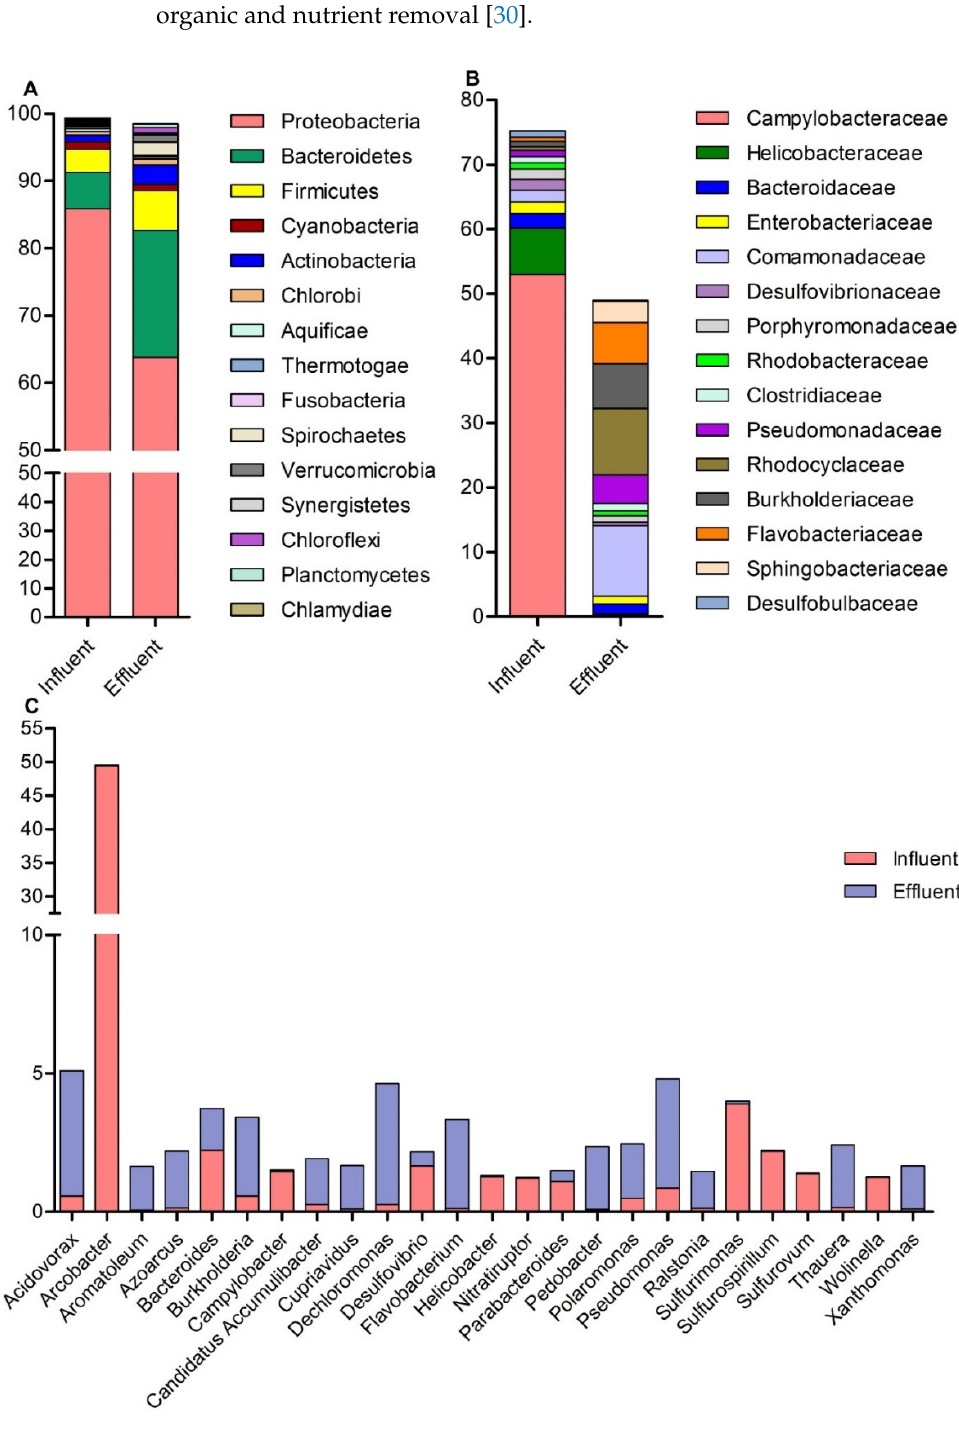
Figure 2. Taxonomic analysis of bacterial communities in the influent and effluent metagenomes. Percent abundance of the relatively dominant ( A ) phyla, ( B ) families, and ( C ) genera. The x-axis shows taxa, and the y-axis indicates abundance in percentage. The relative abundance was calculated by normalizing the sequence reads of each bacteria taxon to the total number of bacteria associated sequences reads in the respective metagenome.